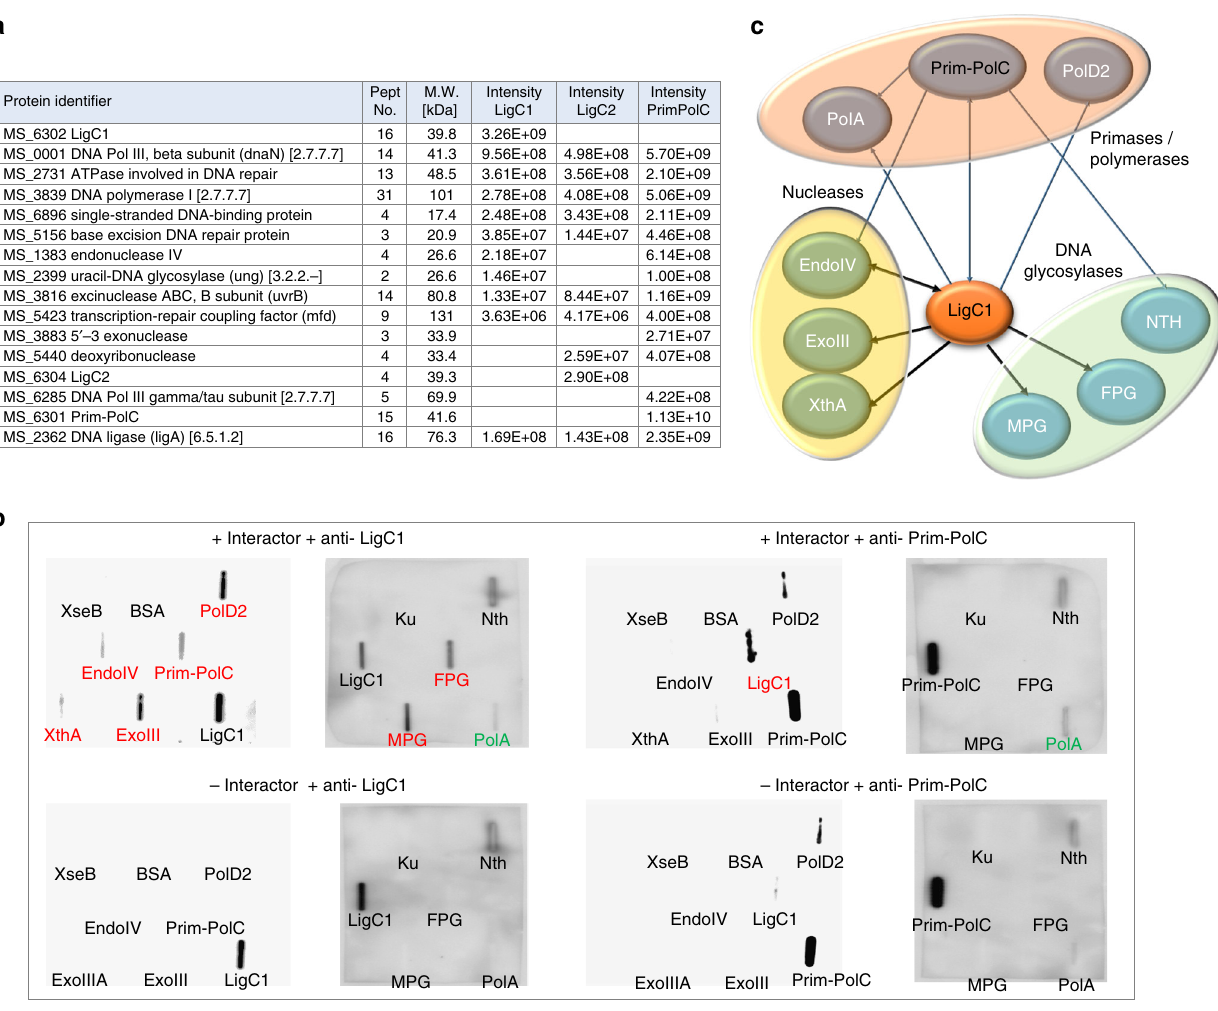
Fig. 1 Interactions between Prim-PolC, LigC proteins and base excision repair elements. a A table showing the DNA repair-associated preys that co-puri fi ed in an eGFP-facilitated af fi nity puri fi cation experiment using LigC and Prim-PolC as baits. b Base excision repair enzymes were puri fi ed as recombinant proteins and interactions with Prim-PolC and LigC1 were con fi rmed by slot-blot analysis, where positive interactions are marked with red, possible weak associations with green and negative interactions with black font, respectively. c Veri fi ed interactions are summarised in a schematic diagram showing that LigC is the major scaffolding protein involved in multiple protein complex